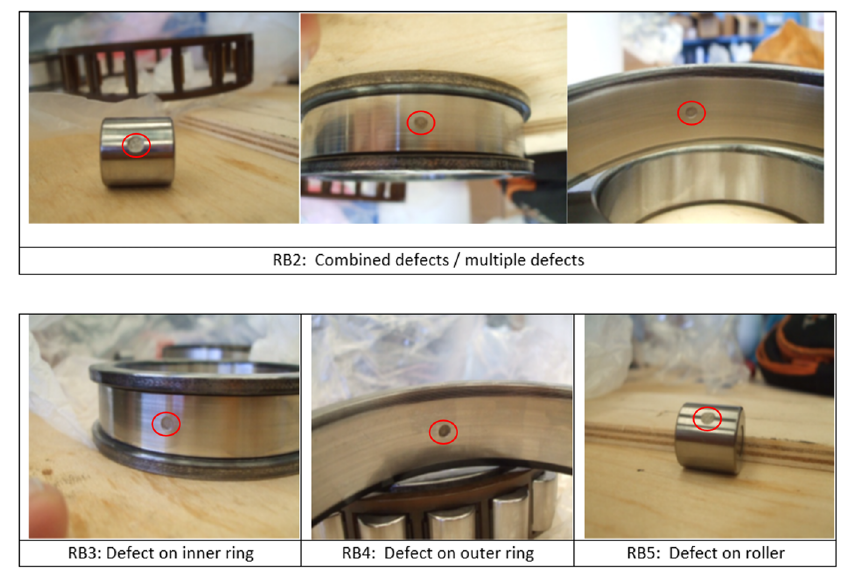
Figure 11. Different types of seeded defects of cylindrical roller bearings (case study-2).